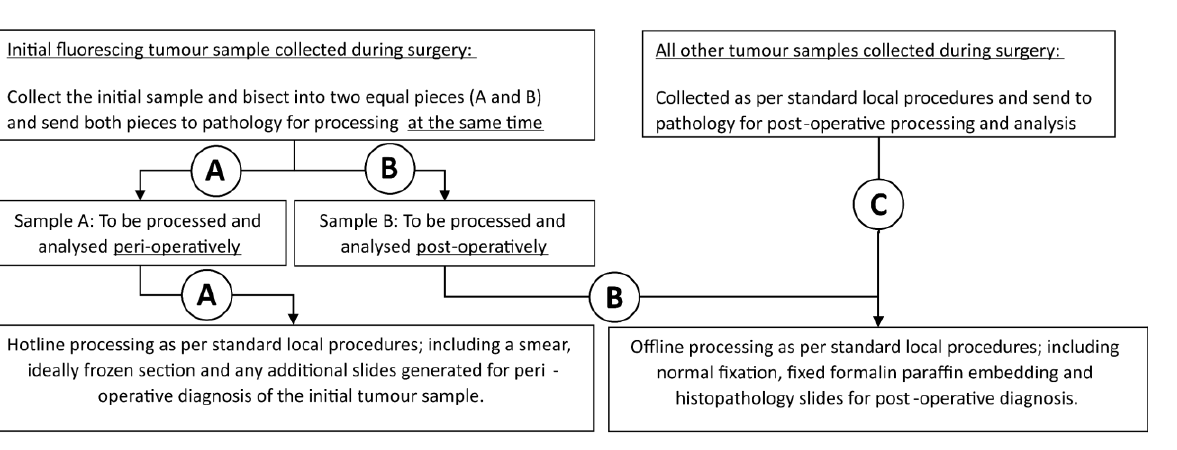
Figure 2. Tumour sample collection and processing. A = peri-operative processing pathway; B = post-operative processing pathway; C = Standard of Care tumour sample collection pathway